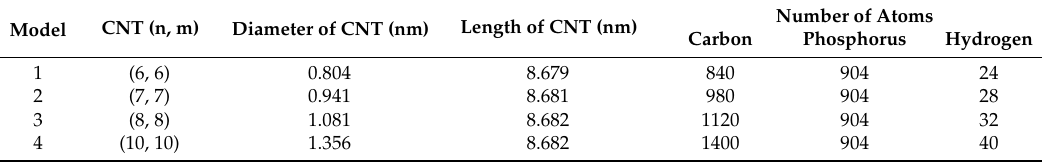
Table 6. Parameters in different